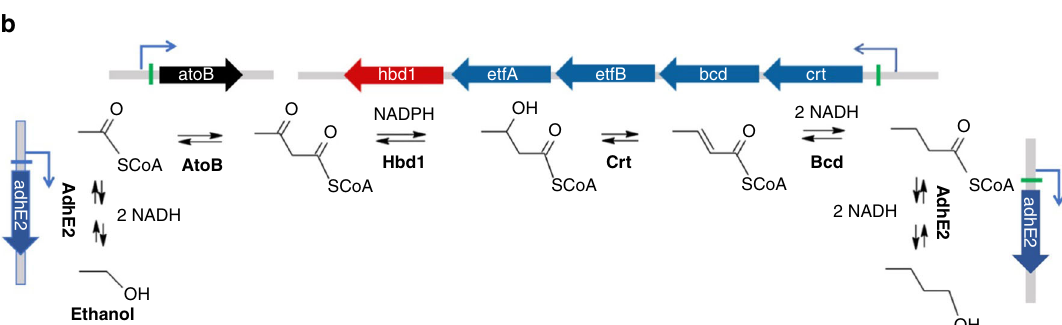
Fig. 1 Metabolic engineering of Clostridium acetobutylicum for n -butanol production. a Elimination of by-products formation (strain CAB1057) by gene deletion. ldhA lactate dehydrogenase, ctfAB acetoacetyl-CoA-acetate CoA-transferase, adc acetoacetate decarboxylase, ptb phosphotransbutyrylase, buk butyrate kinase , adhE2 bifunctional NAD + -dependent aldehyde and alcohol dehydrogenase. b Optimization of acetyl-CoA conversion to n -butanol (Strain CAB1060) using a chimeric pathway derived from three different microorganisms. Blue C. acetobutylicum ; black E. coli , red C. kluyveri ; Green boxes are Rex binding sites. atoB acetoacetyl-CoA thiolase/synthase , hbd1 NADP + -dependent 3-hydroxybutyryl-CoA dehydrogenase , crt crotonase , bcd-etfAB